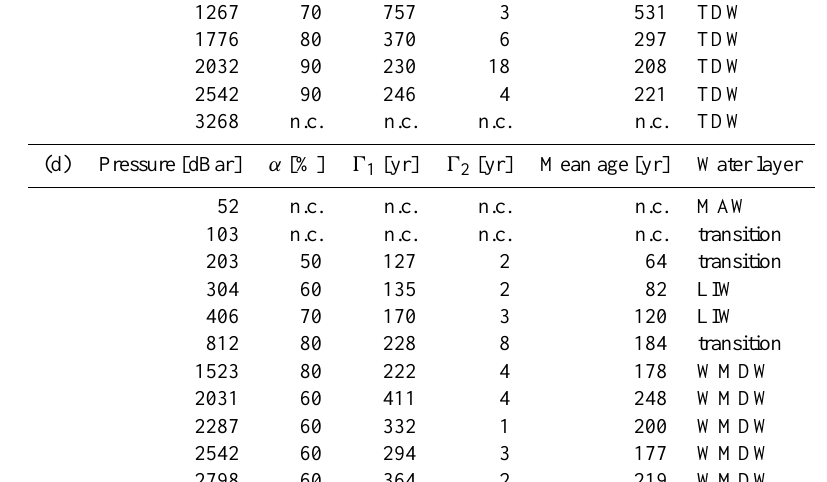
Fig. 14: Determined mean age, ( a ) in the Cretan Sea at station 288 and ( b ) in the Adriatic Sea at station 313 based on SF 6 andanIG-TTDconstrainedbythetransienttracercoupleCFC-12andSF 6 .ThereddotsshowSF 6 meanageresultswitha differenceofmorethan5yearscomparedtotheCFC-12meanage(i.e.non-constrainedmeanage).